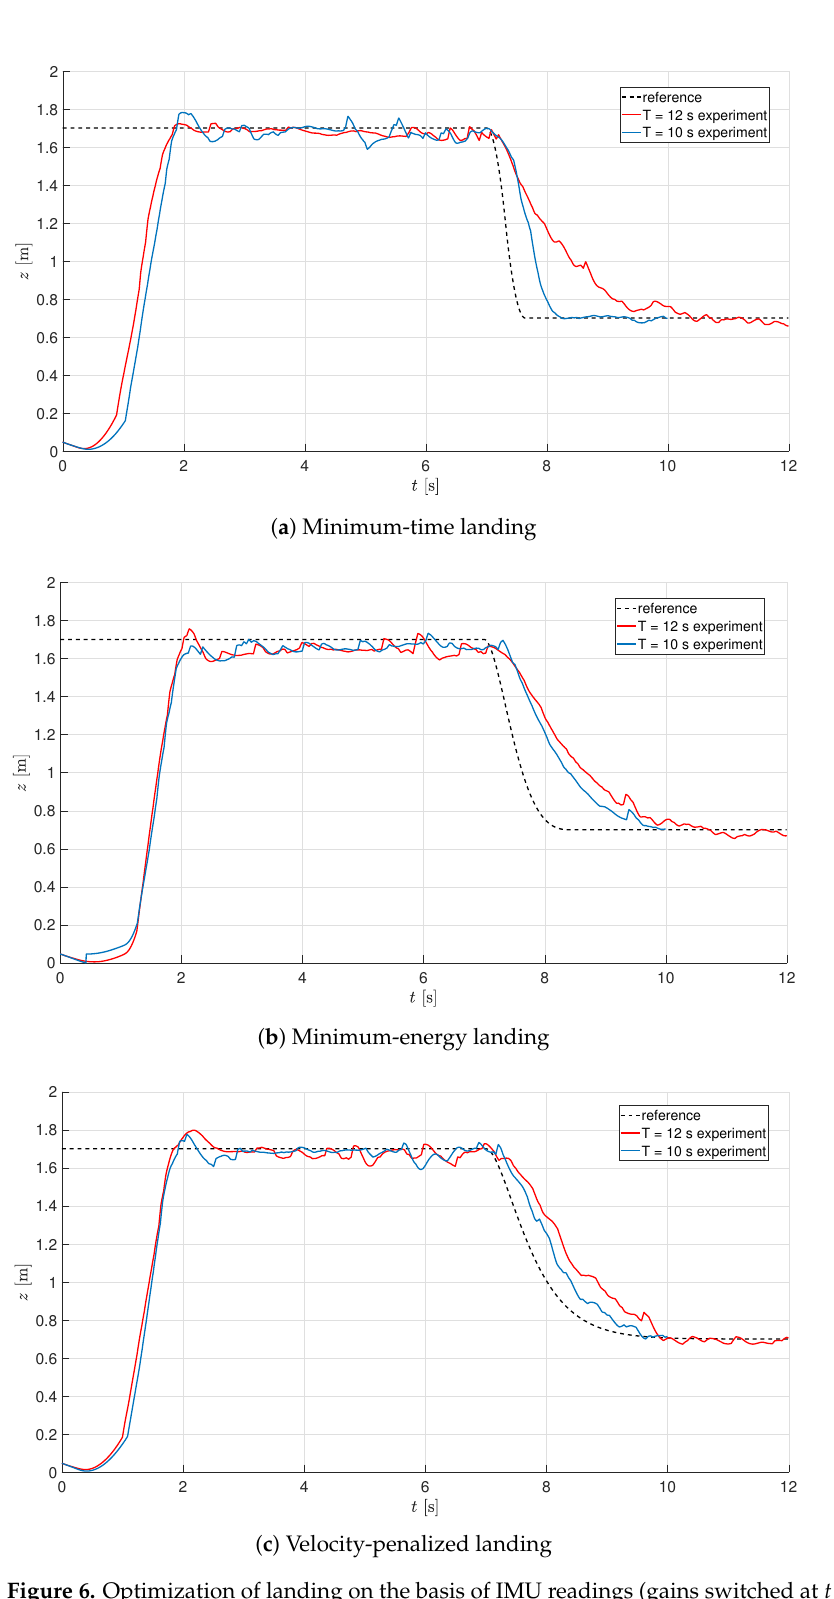
Figure 6. Optimization of landing on the basis of IMU readings (gains switched at t = 3s). As can be seen from Figure 6, the performance of the system is better for a shorter hori- zon of the experiment, what is due to the impact of the environment on the UAV (external disturbances). The latter impedes the tuning procedure, as the values of the performance index are deteriorated along the way, what spoils the results of the optimization. From this reason, the remaining experiments were conducted in a shorter, 10-s